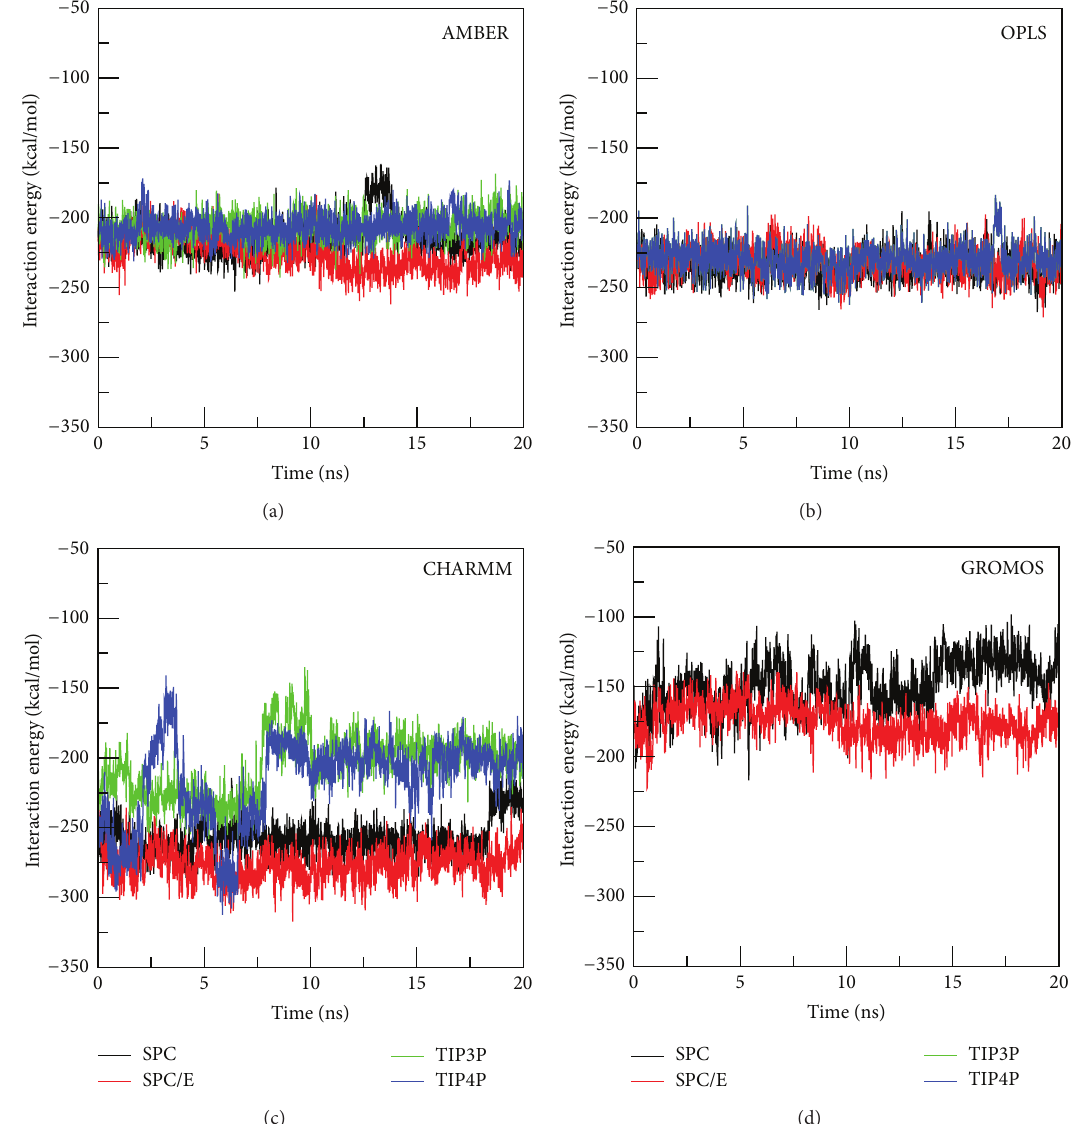
Figure 4: Time dependence of interaction energies of wild-type NA with Tamiflu during 20 ns simulation with different combination of force fields and water